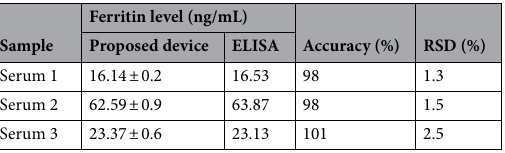
Table 2. Results for using the proposed device for colorimetric immunoassay of ferritin in human serum samples (n = 3).